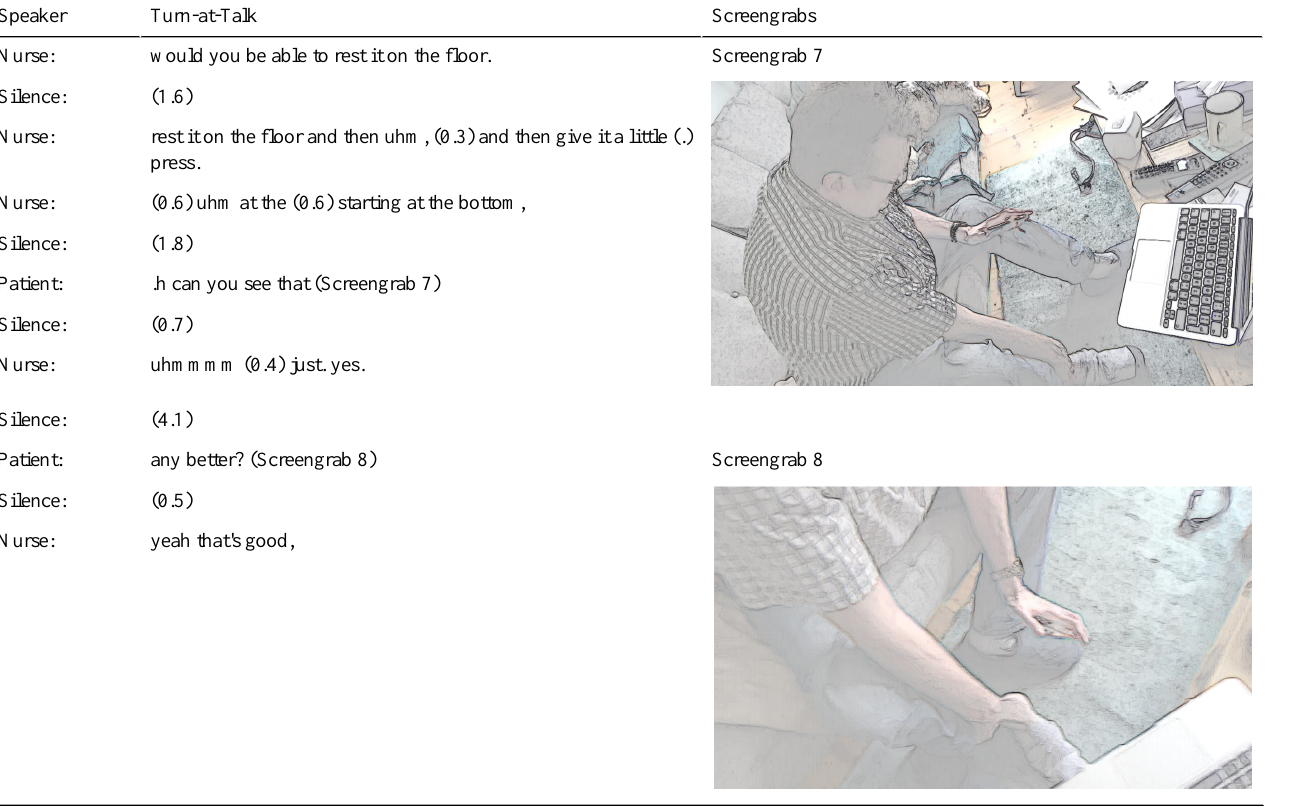
Table 5. Example of a patient reporting oxygen saturation during a video examination (data recorded at the patient end).